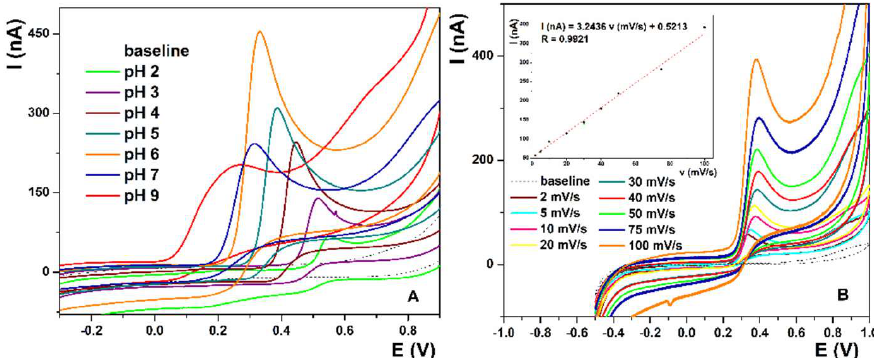
Figure 2. ( A ) Optimization of pH of the 0.1 M PB supporting electrolyte from pH 2 to pH 9. ( B ) CV in 0.1 M PB pH 6 in the potential range from −0.5 V to 1 V at the scan rates from 2 mV/s to 100 mV/s. 0.1 M PB pH 6 in the potential range from − 0.5 V to 1 V at the scan rates from 2 mV/s to 100 mV/s. (inset B) Linear plot of oxidation peak current vs. scan rate. (inset B) Linear plot of oxidation peak current vs. scan